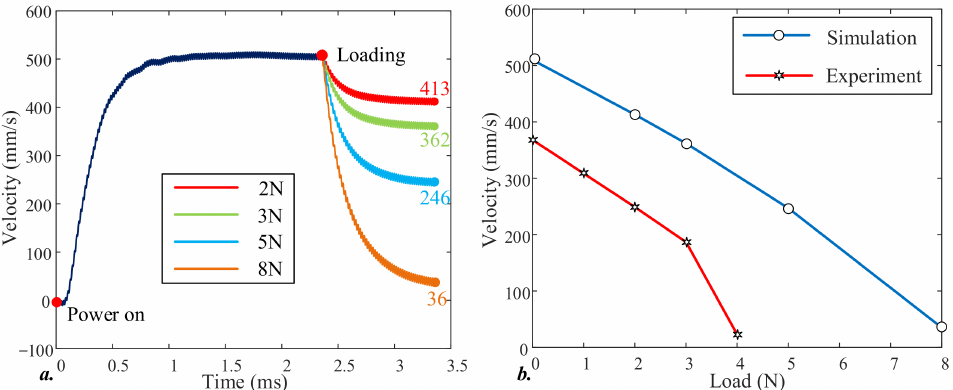
Figure 13. The velocity-load curve of the LUSM by simulations: ( a ) the velocity-time curves with different loads; ( b ) comparison between simulation results and experimental